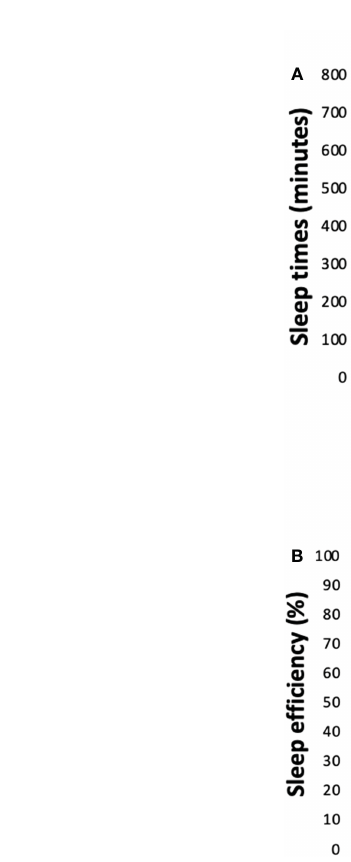
FIGURE 1 Actigraphy measured sleep variables ( A , sleep times, B , sleep ef fi ciency) for overweight/obese women with PCOS (n=39) and healthy controls (n=21) of a similar age and weight presented as means including the 95% CI. P-values are adjusted: controlling for being in a relationship, having children, BMI and waist circumference as covariates. H, hours; min, minutes; TIB, time in bed; TST, total sleep time; WASO, wakefulness after sleep onset. Sleep ef fi ciency: total sleep time/time in bed x